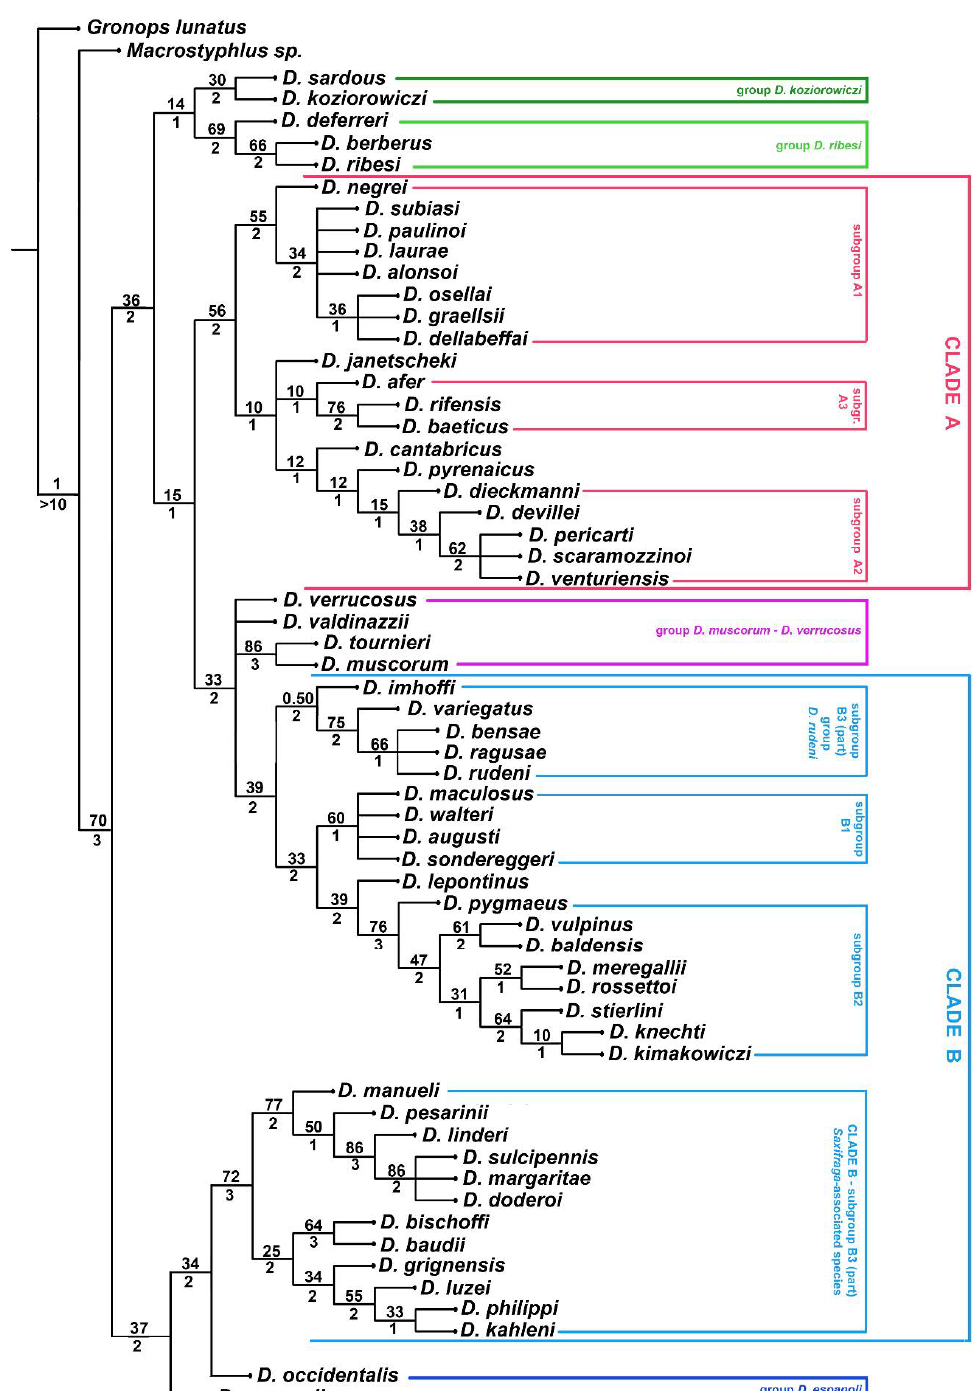
Figure 6. Morphological analysis. Maximum Parsimony consensus tree. Numbers above branches indicate symmetric resampling; numbers below branches indicate Bremer support. Length 281, consistency index = 0.45, retention index = 0.82. Clades and species group are indicated as shown by the Bayesian analysis.